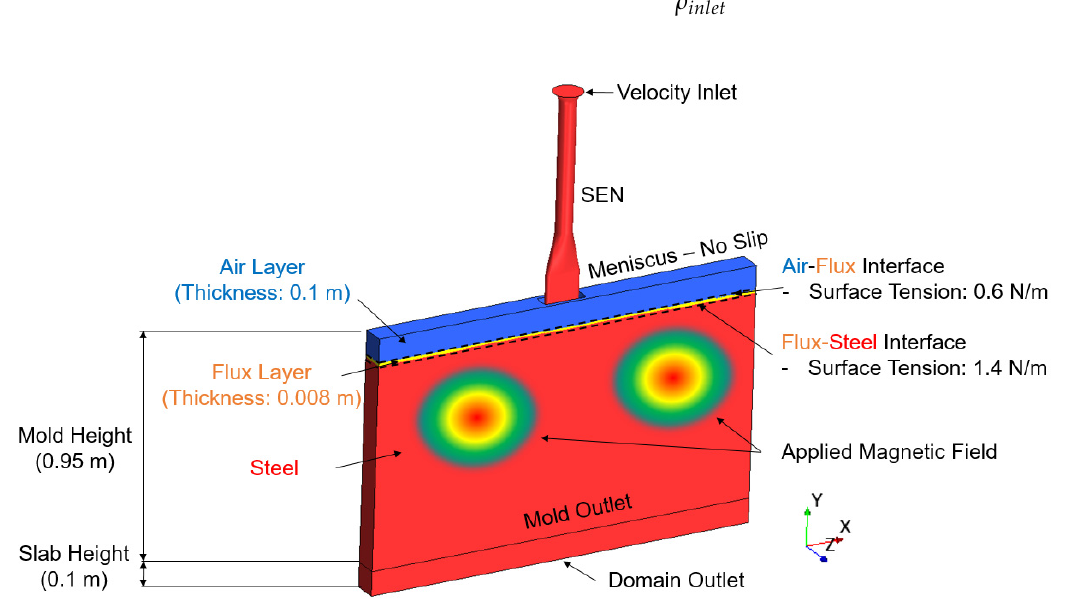
Figure 1. Computational domain and boundary conditions.